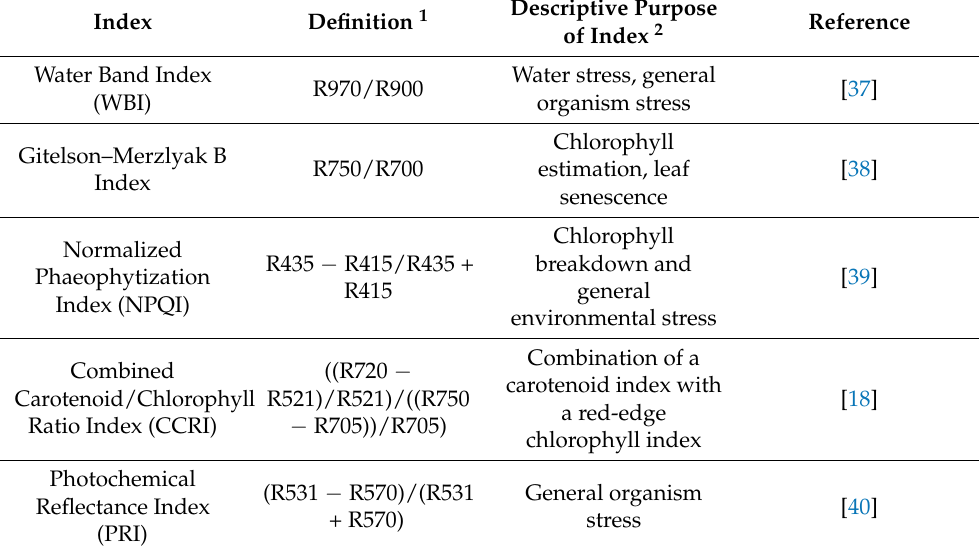
Table 3. Spectral indices